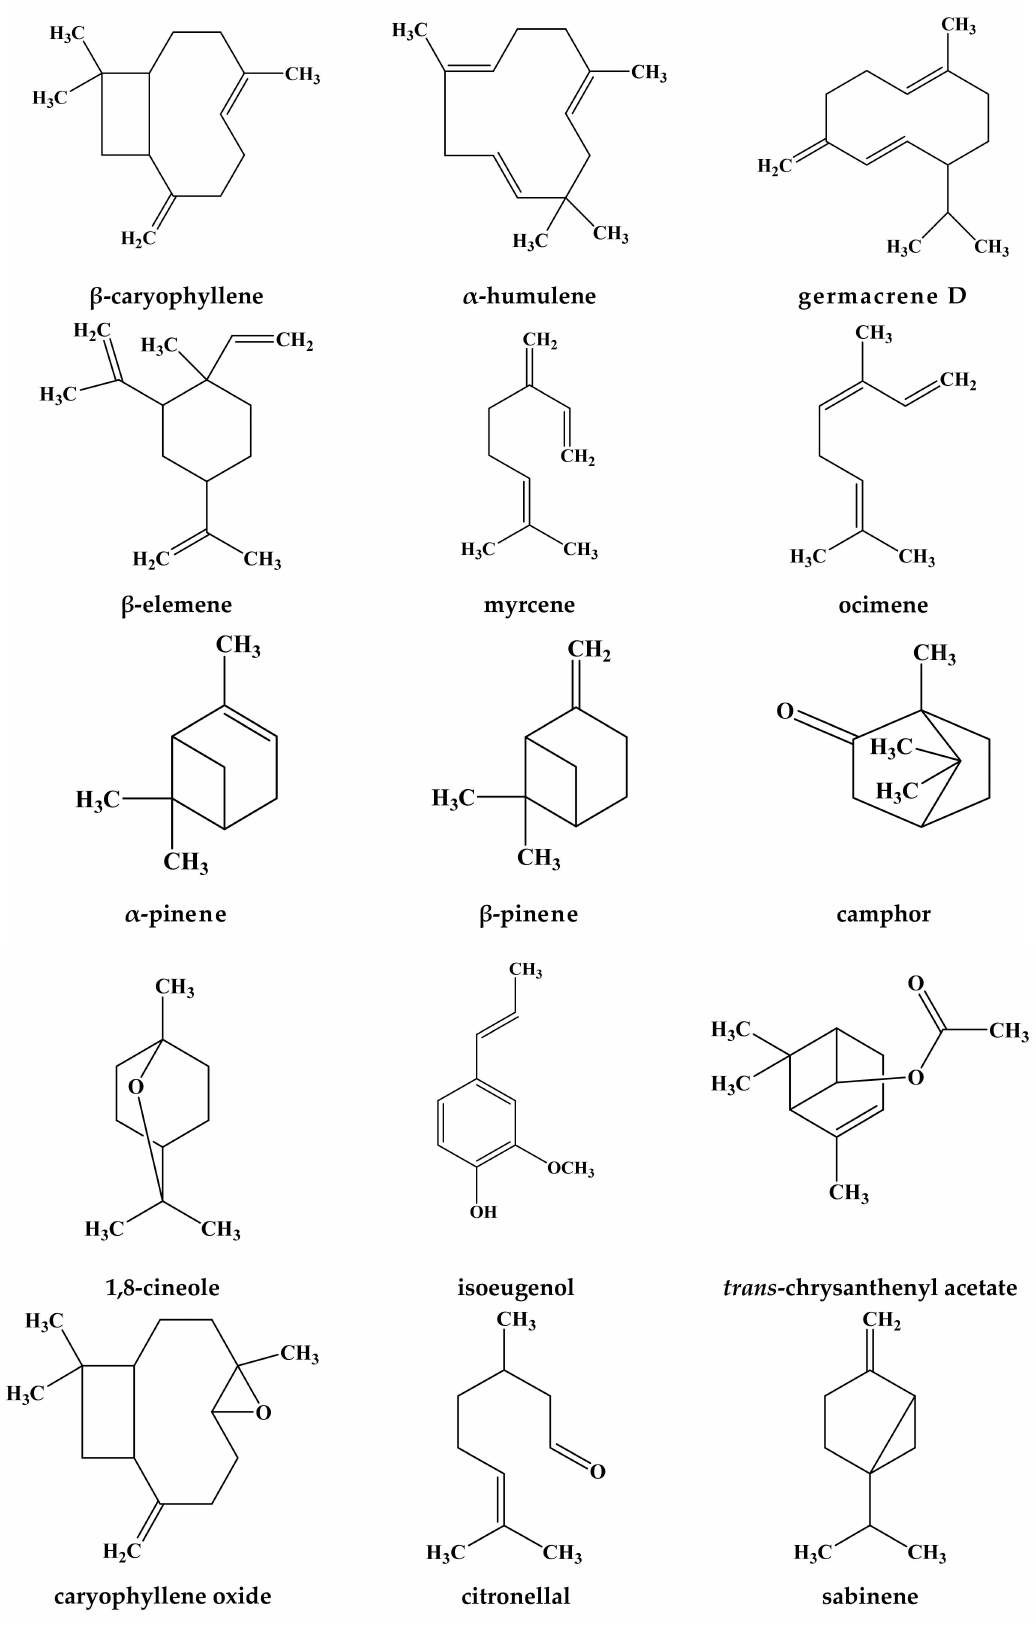
Figure 2. The chemical structure of the main volatile secondary metabolites from Lamium